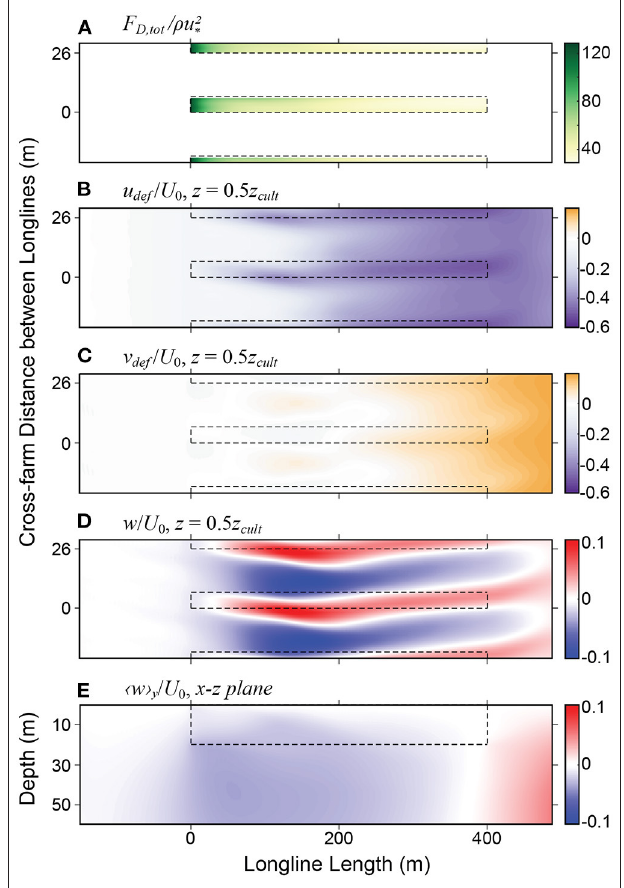
FIGURE 4 | Mean statistics of velocity deficits from LES solution with a maximum canopy and deep mixed layer depth: (A) Magnitude of the vertically integrated drag force per unit horizontal area normalized by ρ u 2 ∗ (B) Streamwise velocity deficit u def , normalized by the inlet bulk velocity U 0 ; (C) Lateral velocity deficit v def , normalized by the inlet bulk velocity U 0 ; (D) Normalized vertical velocity w / U 0 at depth z = 0.5 z cult ( z cult is the cultivation depth). (E) Normalized vertical velocity h w i y / U 0 in the x − z plane, averaged in the cross-farm y -plane. The black dashed rectangles outline the regions occupied by the